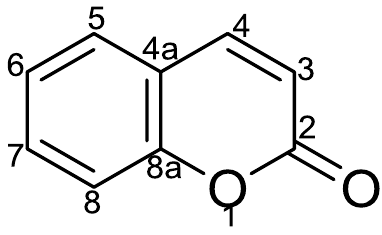
Figure 1. Chemical structure and IUPAC numeration of